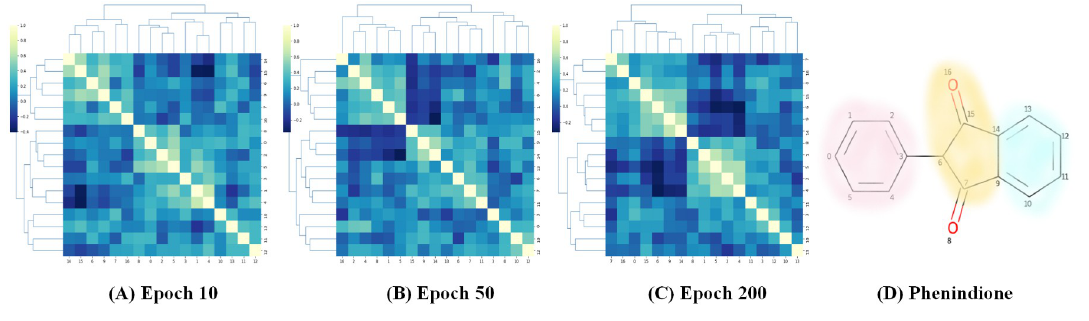
Fig 8. Heat maps of the atom similarity matrix for drug